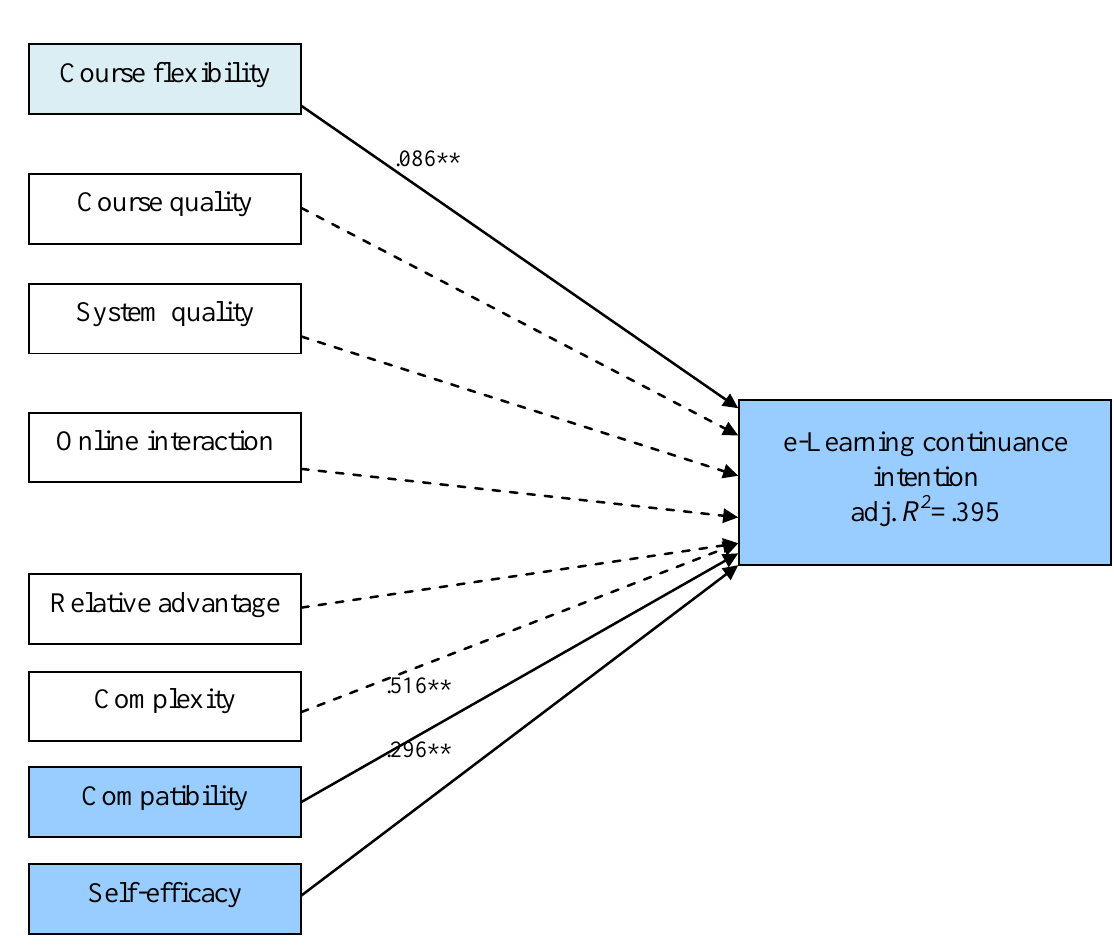
Figure 2. Model of factors affecting learners' e-learning continuance intention Note: Solid lines represent significant results, whereas dotted lines represent insignificant results; **p <